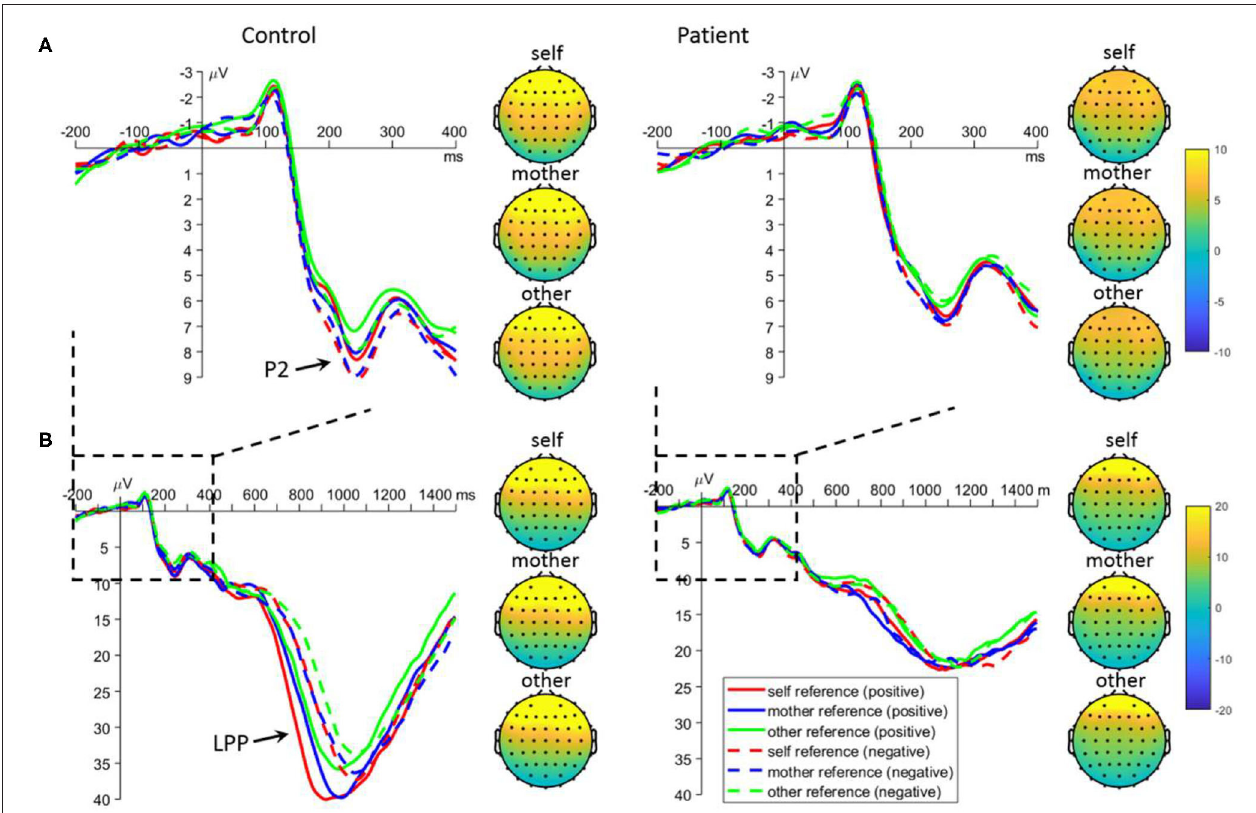
FIGURE 3 | Mean event-related potential waveforms and topographies in response to negative and positive self-, mother-, and other-referential stimuli among patients with first-episode schizophrenia and healthy controls during encoding phase in frontal electrodes. Data were averaged across AF3, AF4, F3, and F4. The waveforms in subplot (A) are locally enlarged images of the waveforms in subplots (B) so as to highlight the P2 component.